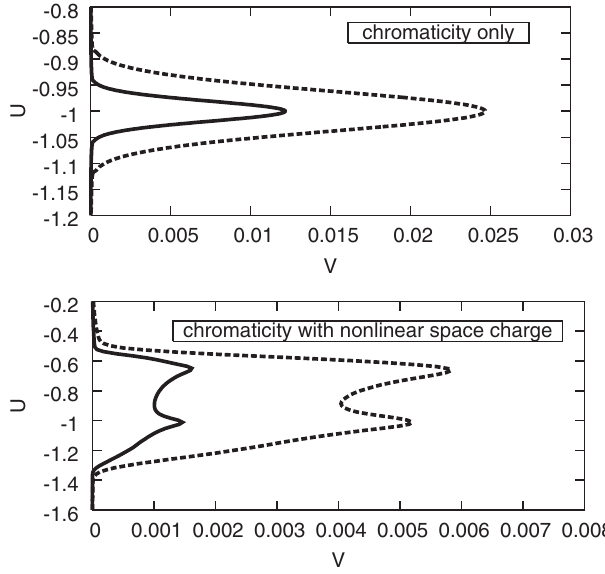
FIG. 8. Stability due to chromaticity effect as given by the dispersion relation [Eq. (7)], for dashed lines the momentum spread is doubled regarding to solid lines. Top plot: chromaticity only (with linear space charge); bottom plot: chromaticity effect taking into account nonlinear space charge for waterbag distri- bution. Note different axis